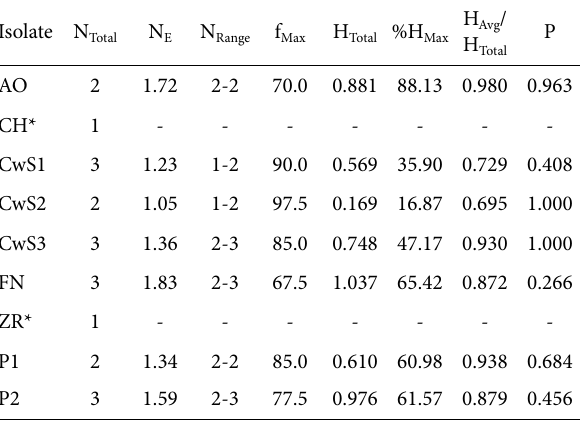
Table 2. Phylogenetic group diversity of nine Citrus tristeza virus isolates based on the results of the SSCP analysis and the classifica- tion, as proposed by Nolasco et al .